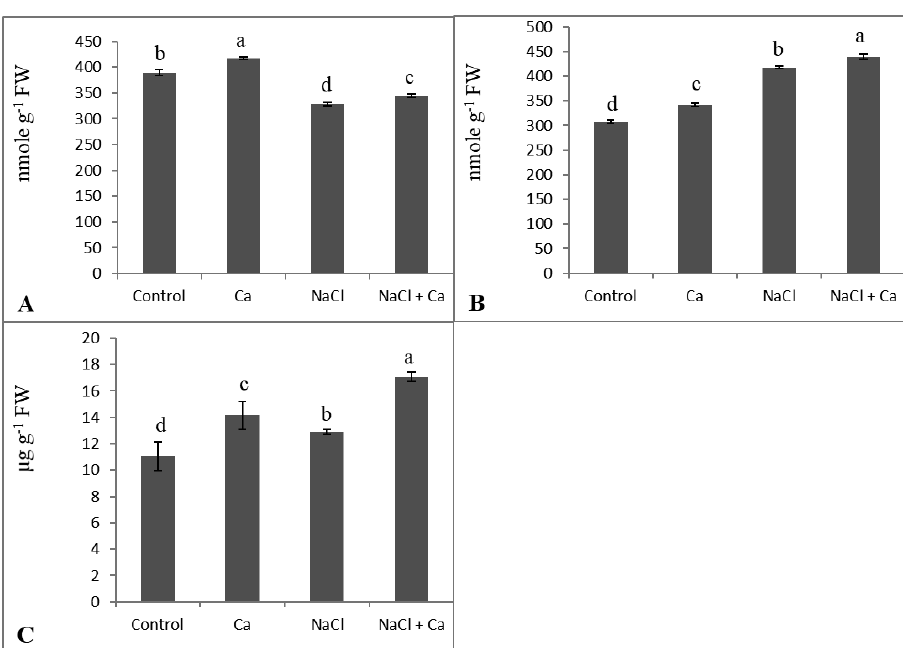
Fig. 6: Effect of salinity stress (100 mM NaCl) on content of (A) ascorbic acid, (B) reduced glutathione and (C) tocopherol in soybean ( Glycine max L.) with and without calcium supplementation. Data is mean (±SE) of three replicates and bars with different letters denote significant difference at P ≤ 0.05